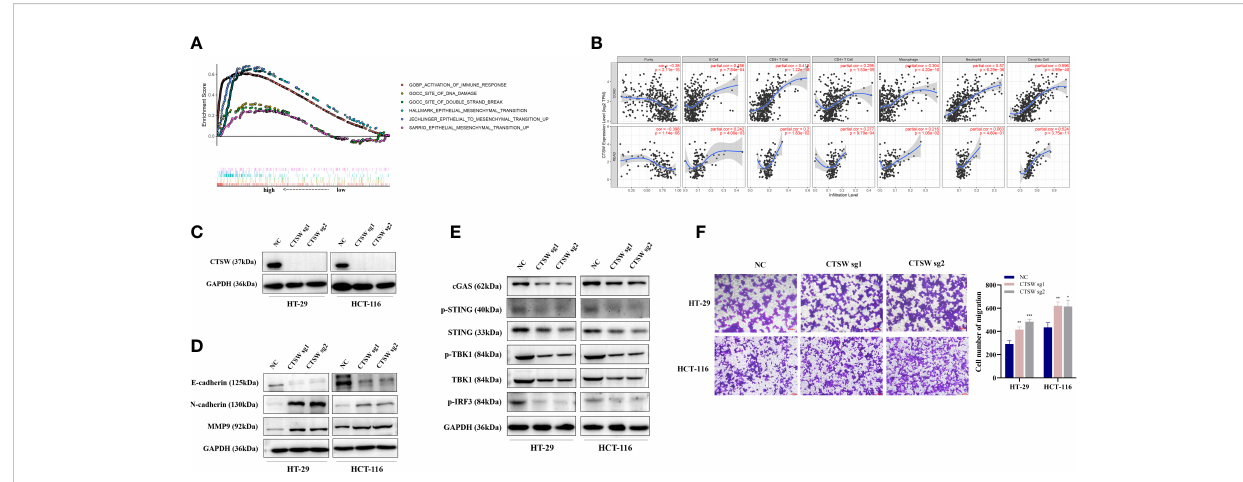
FIGURE 6 The biological function of CTSW in CRC immunity and metastasis. (A) The TCGA-CRC dataset was divided into CTSW-high and CTSW-low expression group based on CTSW expression. GSEA analysis demonstrated that the differentially expressed genes were signi fi cantly associated with immunity, EMT, and DNA damage repair pathways; (B) TIMER analysis showed a signi fi cant positive correlation between CTSW and CD8 + T cells, CD4 + T cells, and neutrophils in CRC; (C) Western blot assay validated the knockout ef fi ciency of CTSW in HT-29 and HCT-116 cells; (D) Western blot assay probed the expression of EMT-related proteins in CTSW -KO cells; (E) Western blot assay showed the expression of cGAS-STING-related genes in CTSW -KO cells; (F) The migratory capability of CRC cells after CTSW knockout was tested by transwell assay. * p < 0.05; ** p < 0.01; *** p <